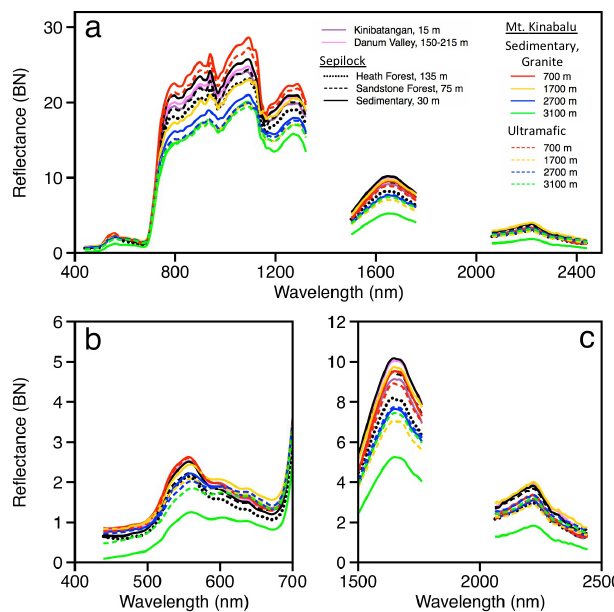
Figure 3. ( a ) Mean canopy reflectance spectra at each site derived from pixels suitable for chemometric analysis following prescreening within each collection location. Zoom images of spectra are provided for ( b ) visible and ( c ) shortwave infrared regions to reveal subtle features associated with varying chemical concentrations.